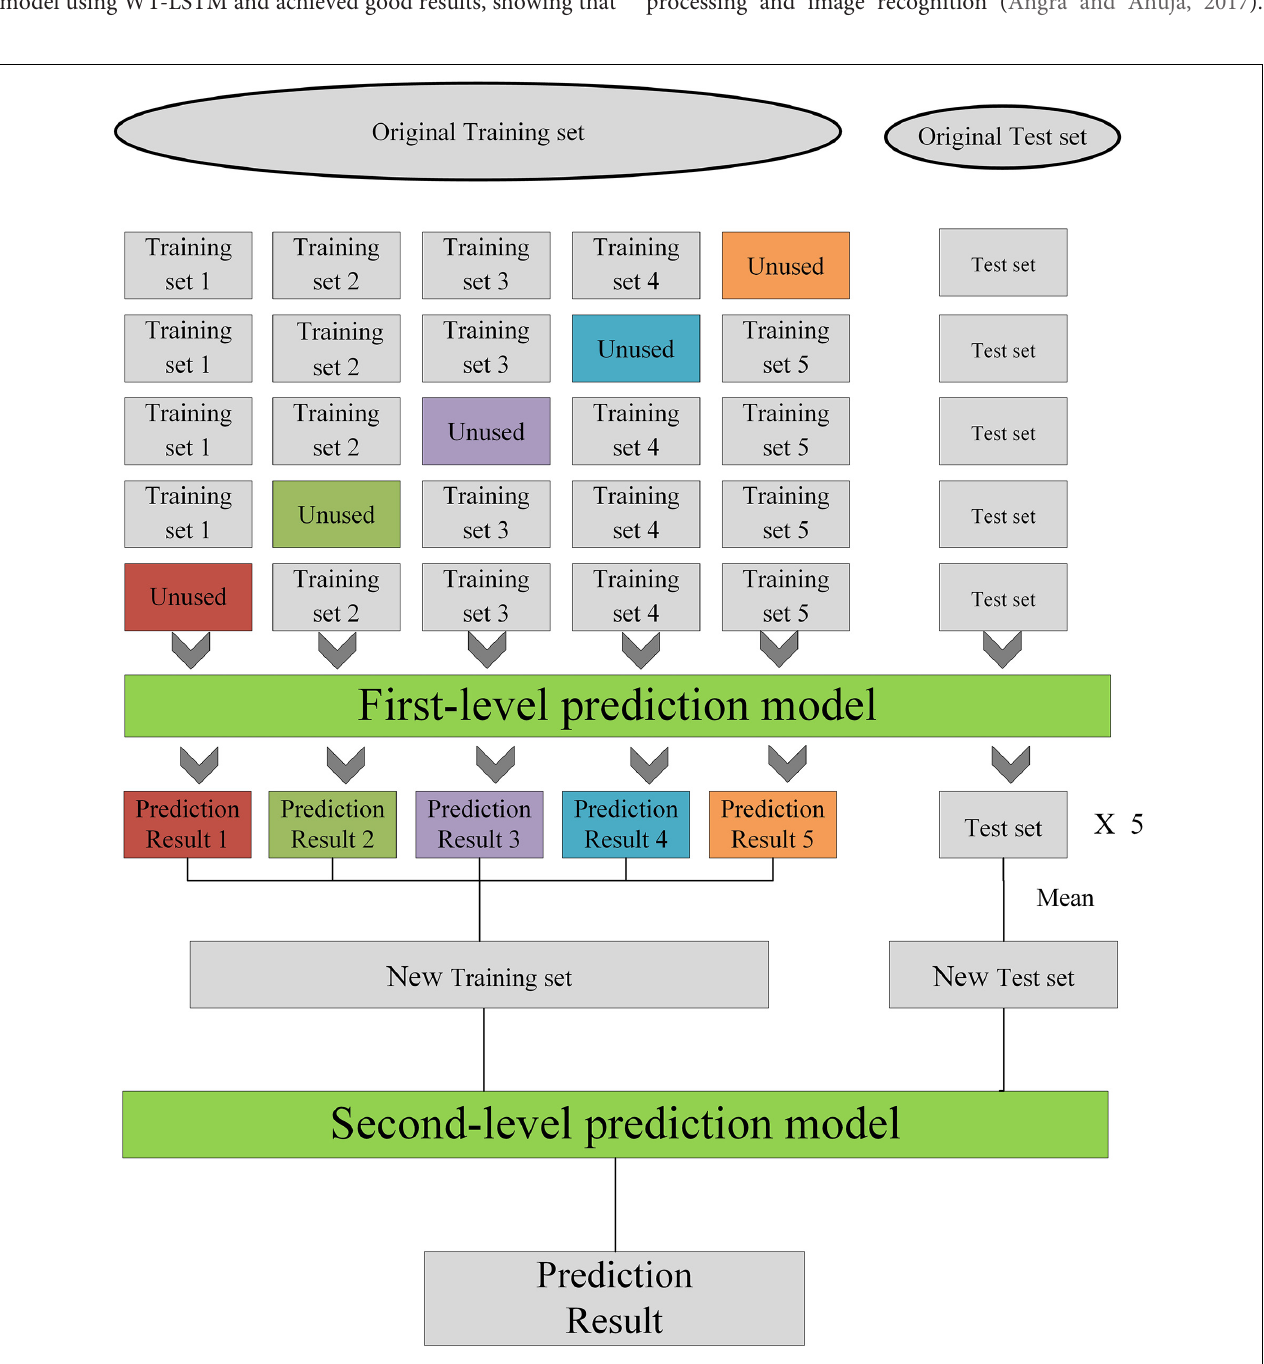
FIGURE 2 | The framework of the stacking